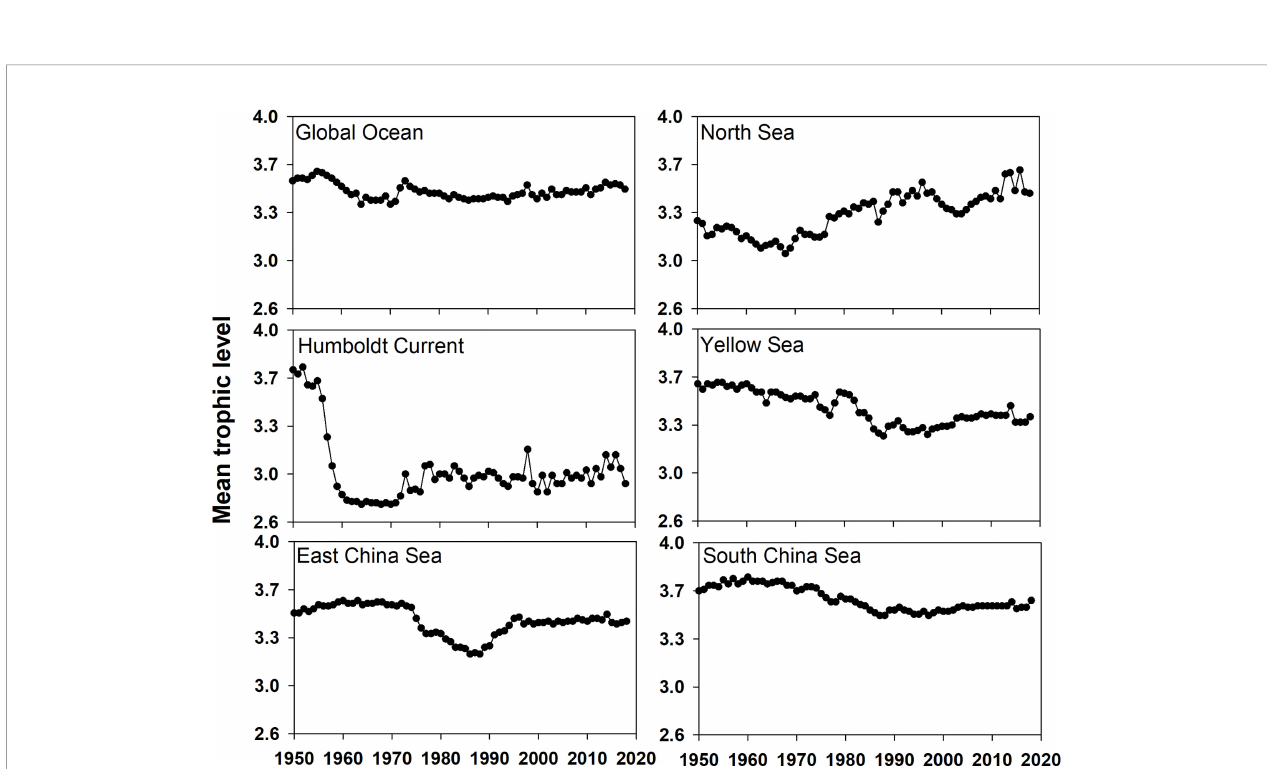
FIGURE 4 | Mean trophic level of fi sheries catch in the global ocean and fi ve LMEs from 1950 to